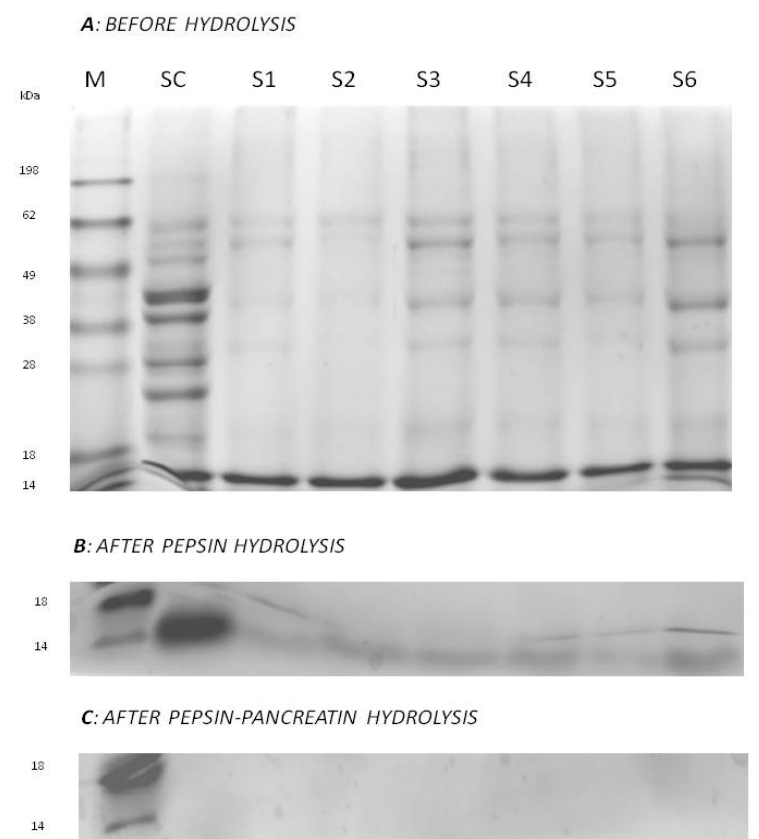
Figure 2. The SDS-PAGE profile of proteins from beef steak obtained before hydrolysis ( A ), after pepsin hydrolysis ( B ) and after pepsin-pancreatin in vitro hydrolysis ( C ). M—molecular weight marker; SC—control samples; S1–S6—analyzed samples. Table 1. Amino acid content in sous vide beef steak (mg kg − 1